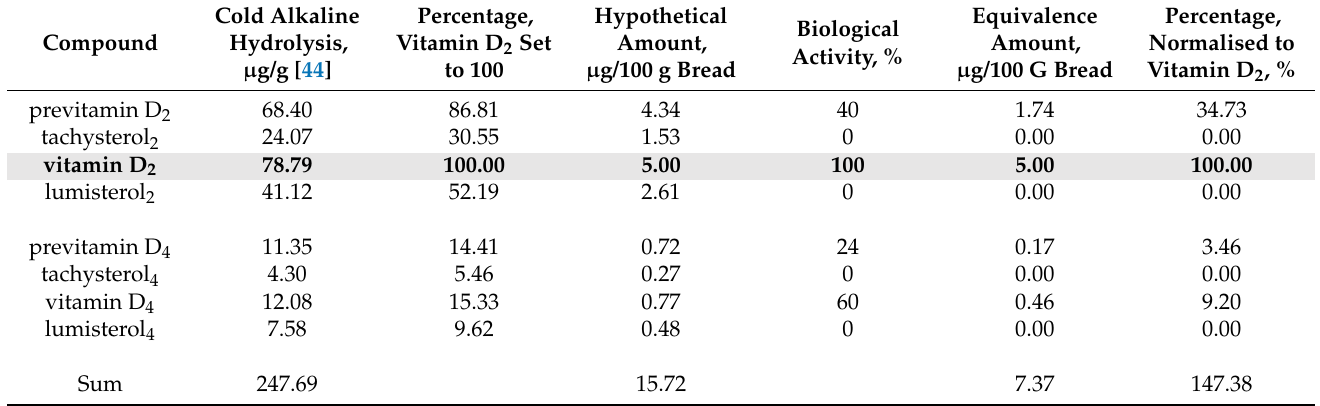
Table 4. Yield from cold alkaline hydrolysis of oyster mushrooms after UV irradiation, determined by HPLC. The yields for the different identified vitamin D isomers as well as precursors and photoinduced side products are provided, as well as the percentage of each compound normalised to the identified vitamin D 2 amount. The hypothetical amounts of all the precursors and photoinduced side products in vitamin D 2 -fortified bread based on an amount of 5 µ g per 100 g bread is provided.